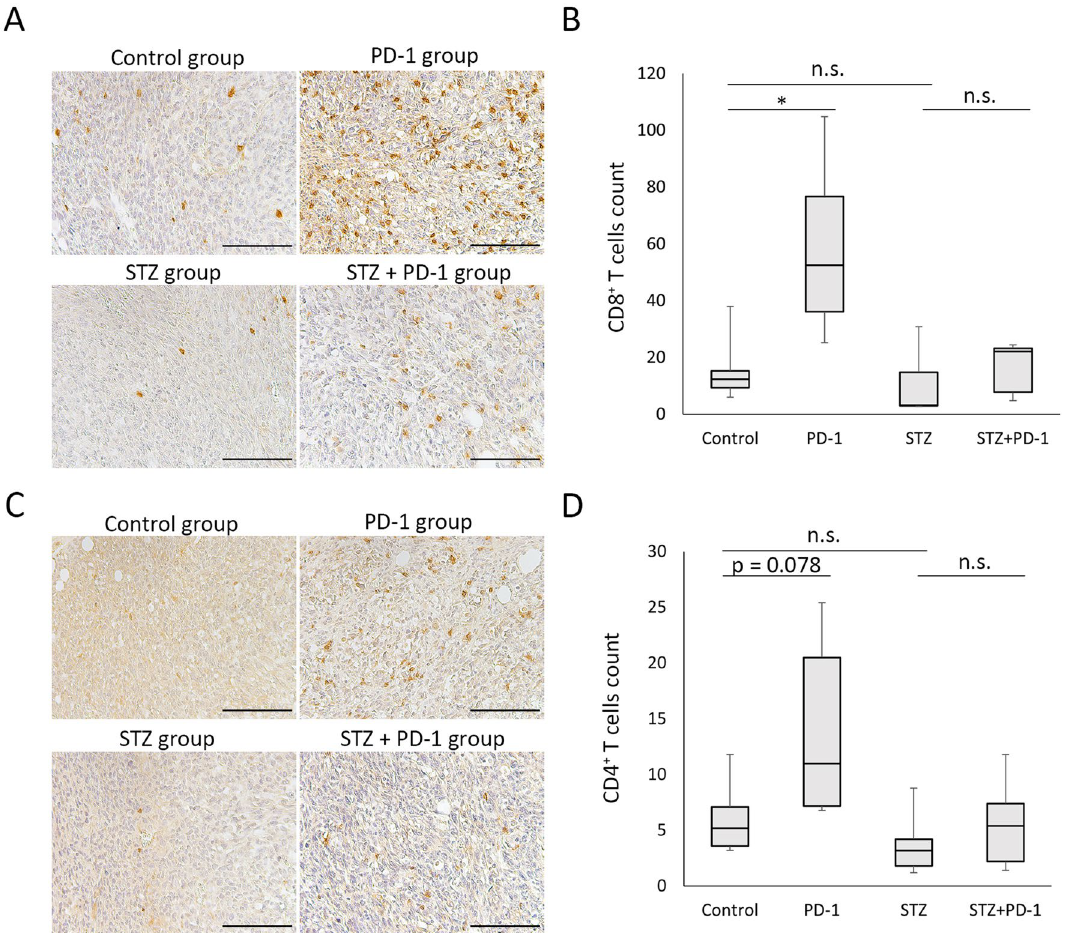
Figure 2. The number of tumor-infiltrating CD8 + and CD4 + T cells after anti-PD-1 antibody treatment is decreased in STZ-induced diabetic mice. Immunohistochemical staining of CD8 + ( A ) and CD4 + T cells ( C ) in MC38 tumor in the control, PD-1, STZ, and STZ + PD-1 groups. Scale bars, 100 µm. The number of CD8 + ( B ) and CD4 + T cells ( D ) in MC38 tumors in control (n = 6), PD-1 (n = 6), STZ (n = 5), and STZ + PD-1 (n = 5) groups. Boxes indicate median values with interquartile range, and whiskers indicate the lowest and highest values. Kruskal–Wallis and Mann–Whitney U tests with Bonferroni correction are used in ( B ), and one-way ANOVA and Tukey’s test are used in ( D ). *P < 0.05. ANOVA analysis of variance, n.s. not significant, PD-1 programmed cell death-1, STZ